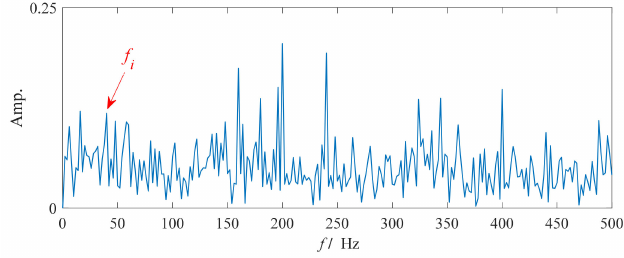
Figure 4. SES of the simulation signal.